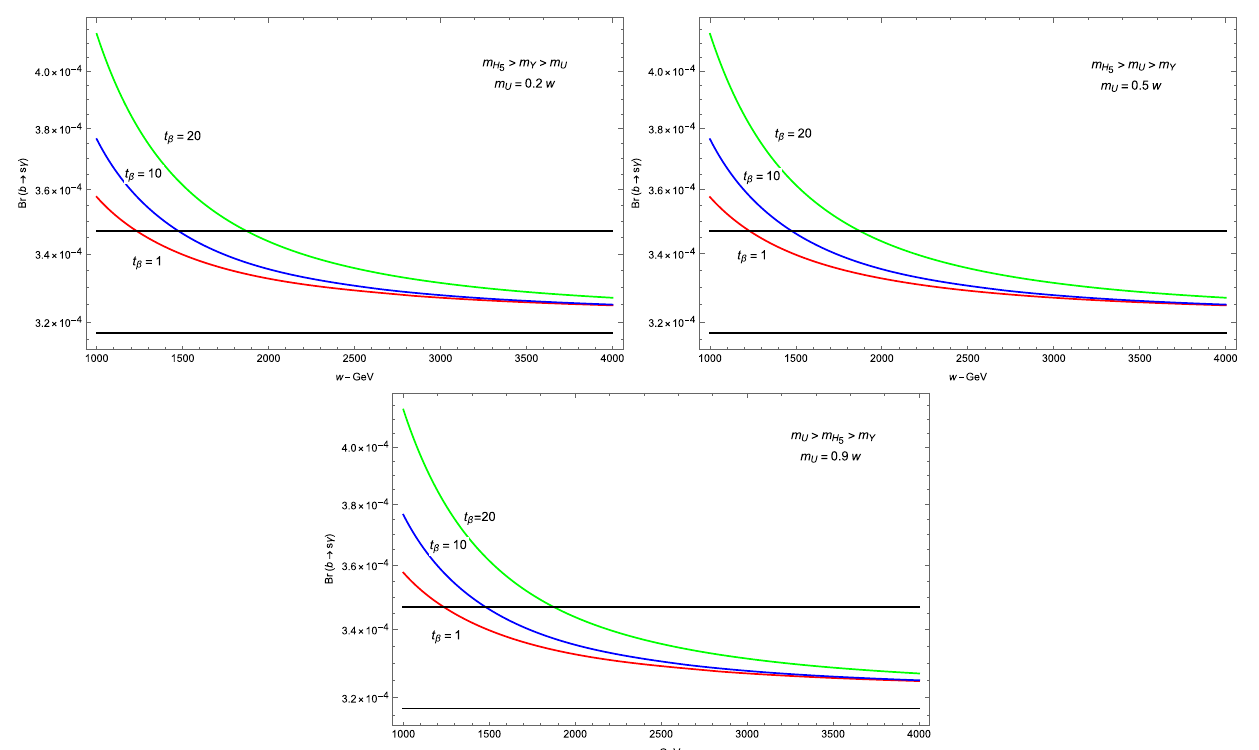
Fig. 5 The dependence of the branching ratio Br ( b → s γ) on the NP scale w in the limit u ,v (cid:14) − f ∼ w ∼ (cid:12) . The solid black lines indicate the current experimental constraint Br ( b → s γ) = ( 3 . 32 ± 0 . 15 ) × 10 − 4